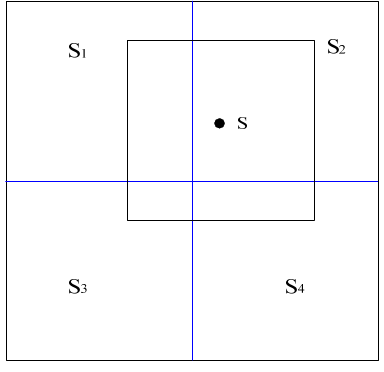
Figure 2. Area used to estimate the moving average of Tropical Rainfall Measuring Mission (TRMM) Multi-satellite Precipitation Analysis (TMPA) data.